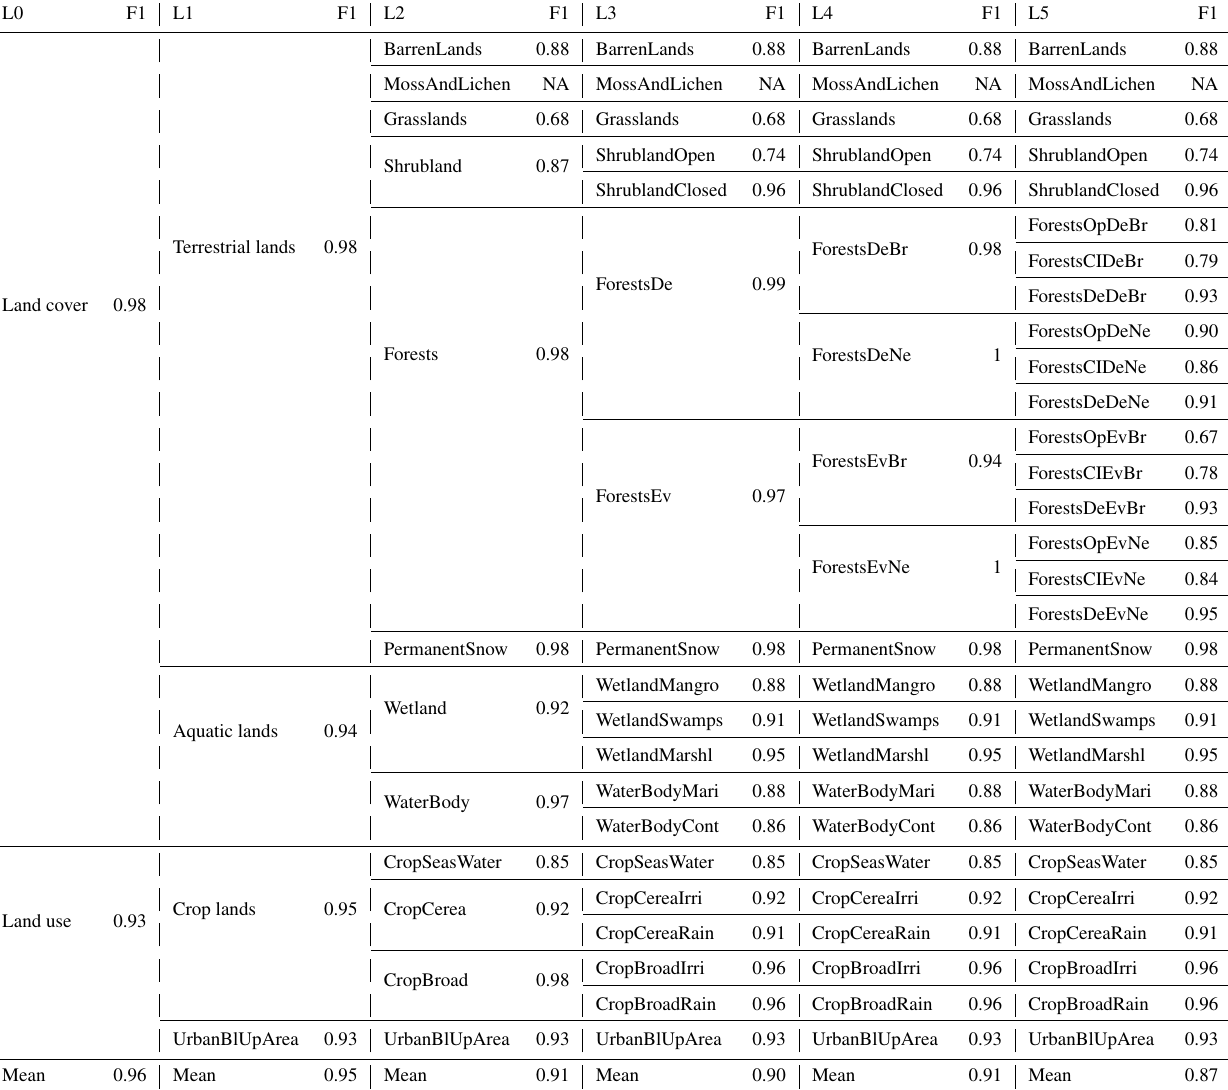
Table 8. Description of the data quality control results of the 2900 pixels for each LULC level (L0 to L5) using the F1 score. The correspon- dence between long and short names of the LULC classes is provided in Table 3. L0